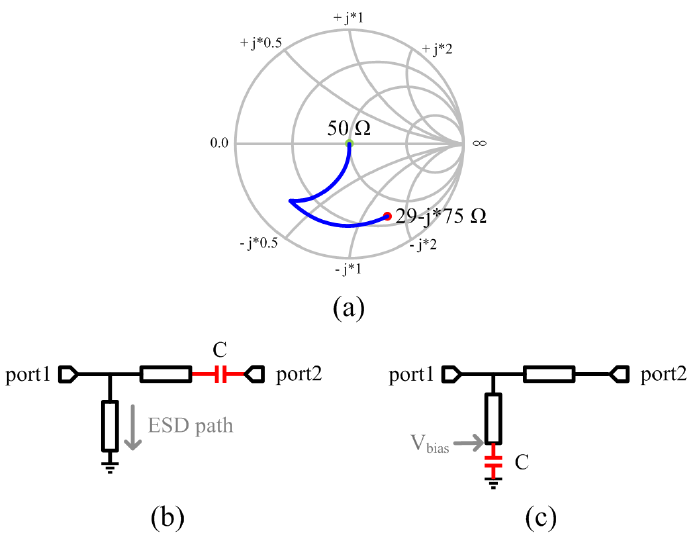
Figure 3. ( a ) Smith chart trajectories for input matching of the PA, ( b ) CPW matching network with series-connected DC-blocking capacitor, ( c ) CPW matching-network with parallel-connected DC-blocking capacitor.